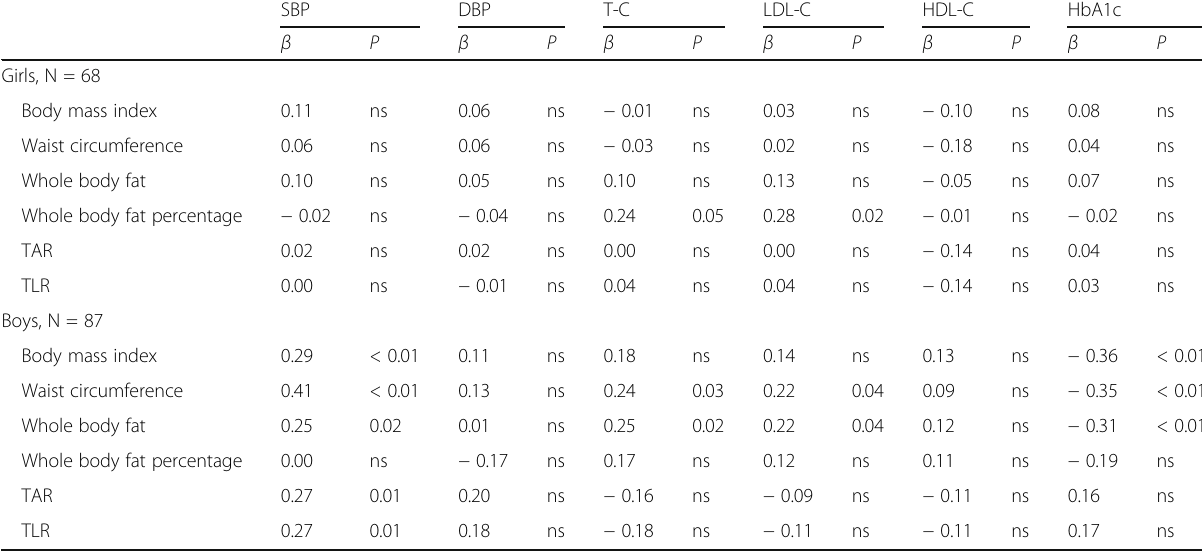
Table 3 Relationships between body fat parameters at baseline and cardiometabolic parameters at